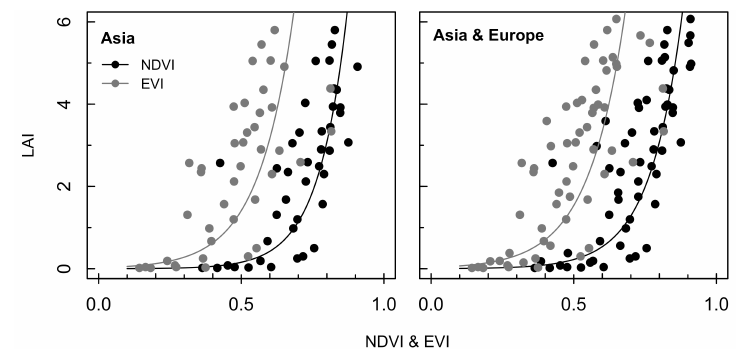
Figure 4. The pooled relationships between LAI and NDVI and between LAI and EVI using the data from the entire growing season. The regressions for Asia includes the data from Haean and Mase (y = e ( 9.92 x − 6.81 ) with R 2 = 0.62 for NDVI and y = e ( 8.07 x − 3.69 ) with R 2 = 0.56 for EVI), while the regressions for Asia and Europe includes Haean, Mase, and El Saler-Sueca (y = e ( 8.73 x − 5.86 ) with